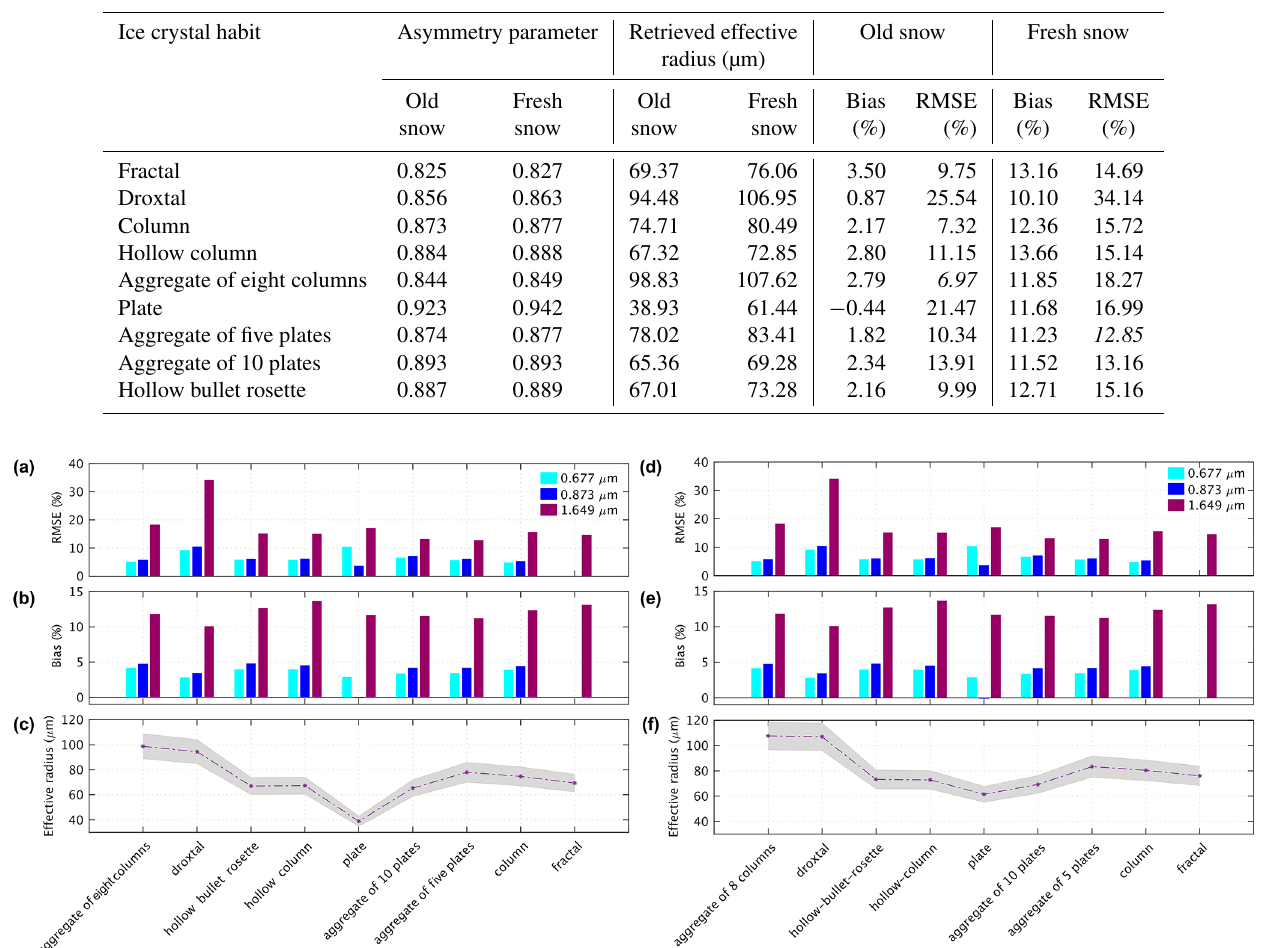
Table 3. Retrieval of the physical characteristics of ice crystals with different shapes in the case of most roughened habits. Numbers in italics indicate minimum root mean square error (RMSE).